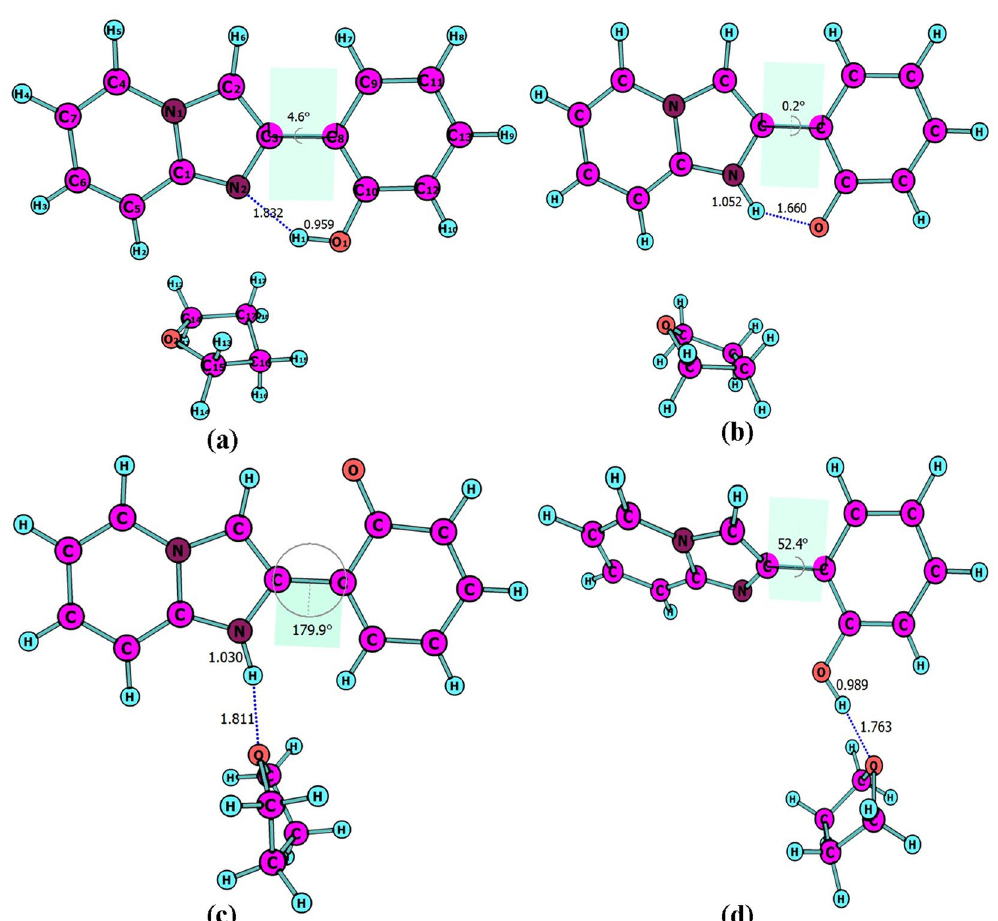
Figure 2. The optimized structures of ( a ) cis-HPIP, ( b ) k-HPIP, ( c ) trans-k-HPIP and ( d ) o-HPIP in the S 0 state. Some crucial bond parameters have been